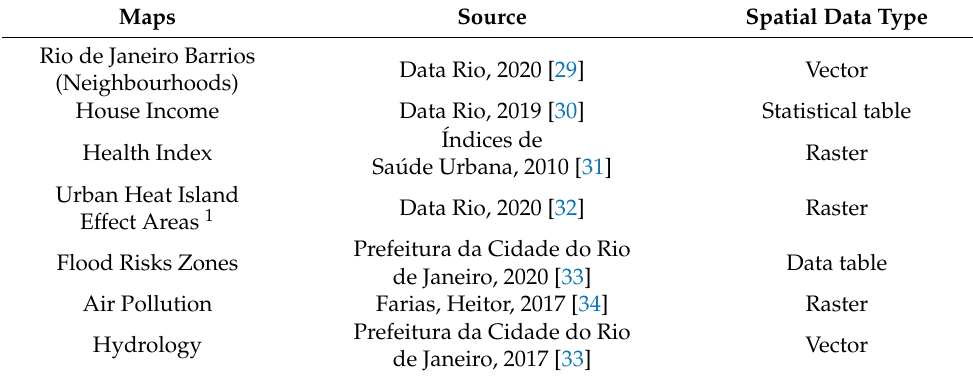
Table 2. Rio de Janeiro case study.